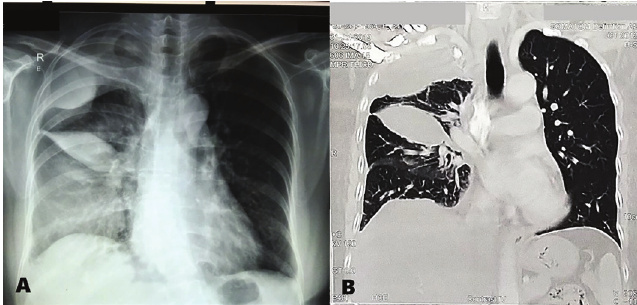
Figure 2. (A) Chest X-ray and (B) Chest CT scan with contrast showing multi-localized right pleural effusion with compressive atelectasis right posterior pulmonary